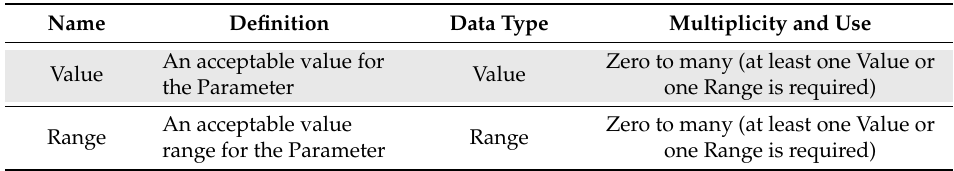
Table 5. Properties of the AllowedValues .